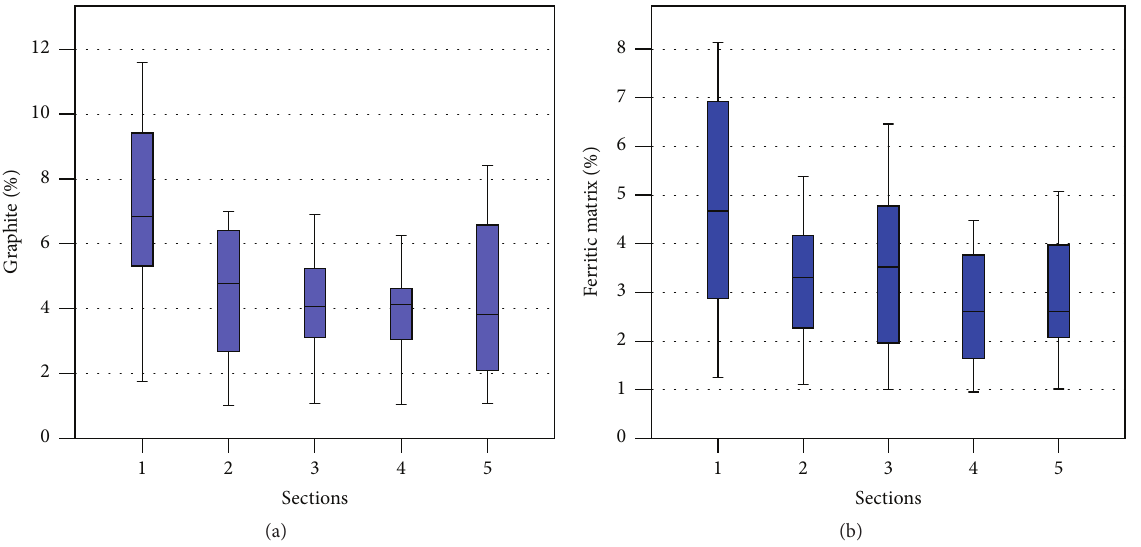
Figure 9: Box plots: (a) nodule sizes; (b) separation distances between nodules.